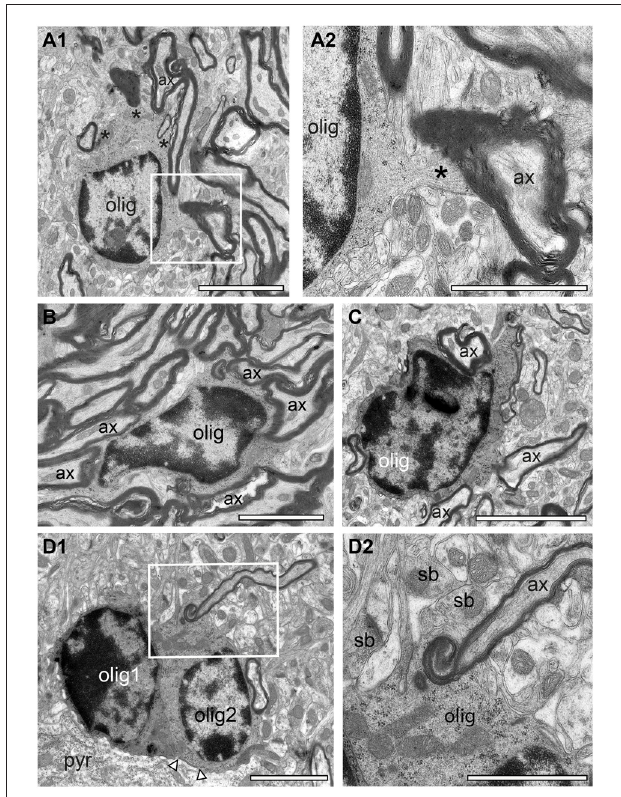
FIGURE 8 | “Active” oligodendrocytes in the adult reeler mouse neocortical mass. (A1) Oligodendrocyte (olig) in the superficial part of the neocortex myelinating several axons (ax) as marked by asterisks. The framed area is shown at higher magnification in (A2) . Scale bar 10 µ m. (A2) High power micrograph of a cytoplasmic finger (asterisk) of the oligodendrocyte (olig) shown in (A1) myelinating an axon (ax). Scale bar 20 µ m. (B,C) Two oligodendrocytes located in the mid (B) and deep (C) portion of the neocortical mass. Both oligodendrocytes are seen to myelinate several axons. Scale bar in (B) 10 µ m, (C) 20 µ m. (D1) Pair of oligodendrocytes (olig1, olig2) next to the cytoplasm of a neuron (pyr) in the deep neocortical mass. Note that the right oligodendrocyte is coupled to the neuron via a gap-junction (arrowheads). The framed area is shown at higher magnification in (D2) . Scale bar 10 µ m. (D2) High power micrograph of the framed area in (D1) showing the process of myelinating an axon (ax). Note several synaptic boutons (sb) in the adjacent neuropil. Scale bar 10 µ m.